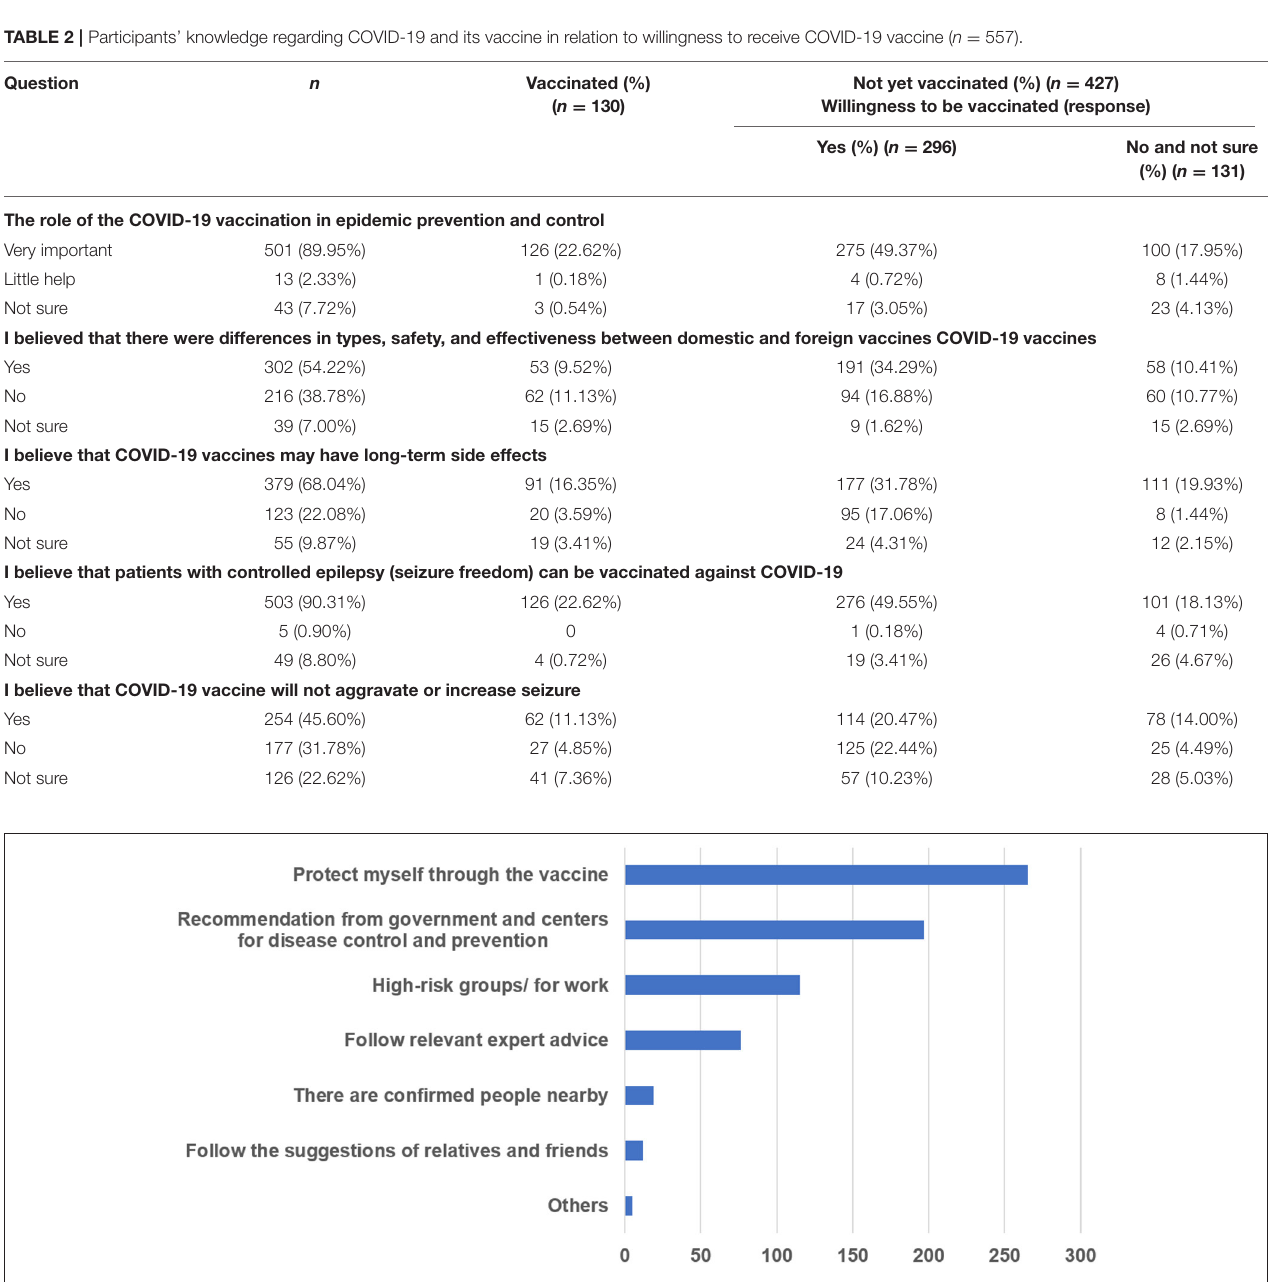
FIGURE 1 | Main reasons for accepting COVID-19